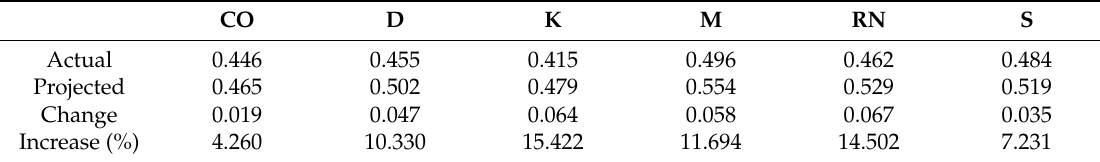
Table 14. Poverty rate due to yield loss by flood in Bangladesh.